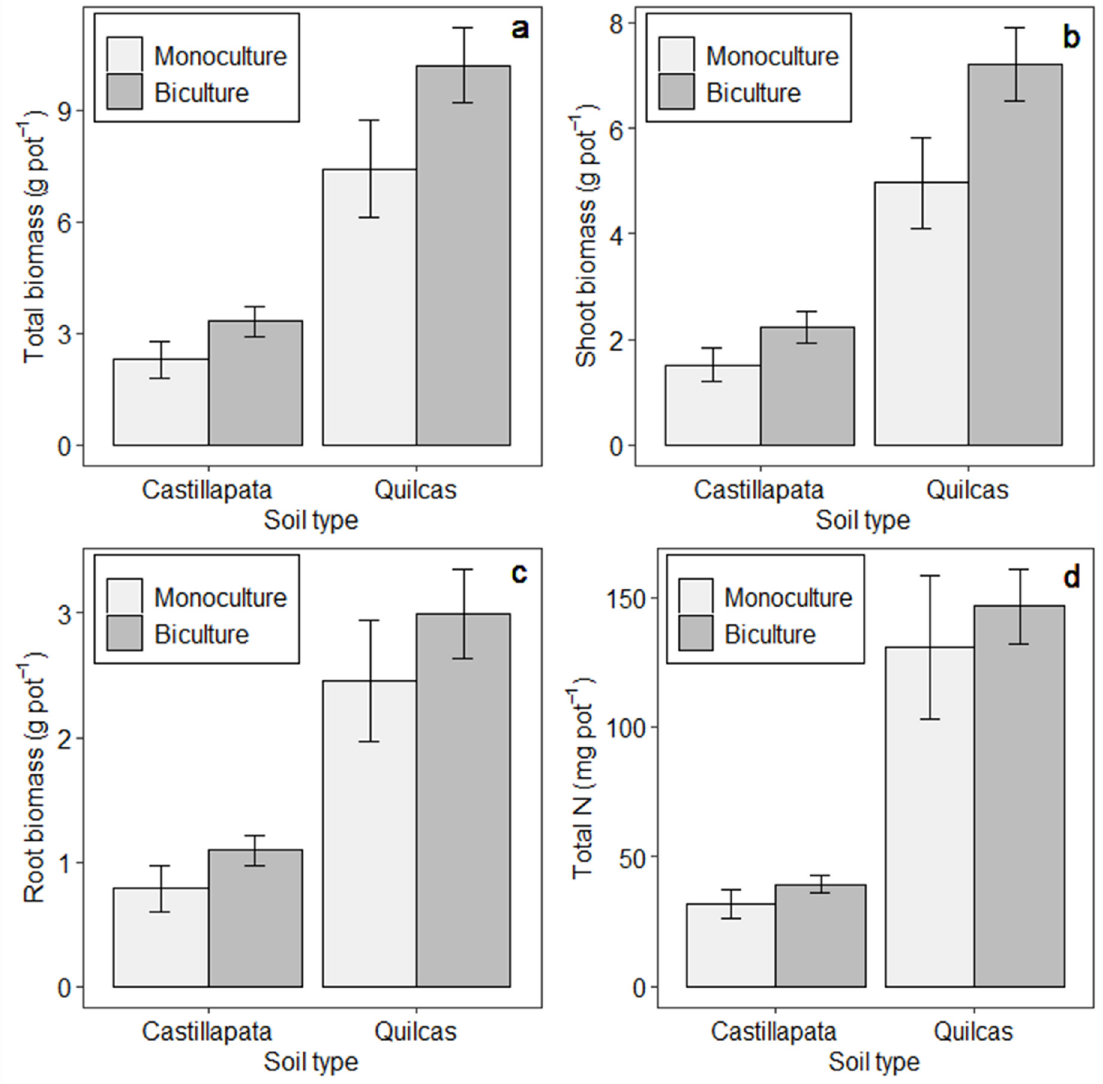
Figure 2. Mean performance metrics of just perennial bicultures vs. monocultures (averaged across treatments with annual species excluded) and presented separately for each soil type. Panels refer to: ( a ) Total biomass production, ( b ) Shoot biomass, ( c ) Root biomass, and ( d ) Total N uptake. Means and standard errors correspond to the original data (without transformation).